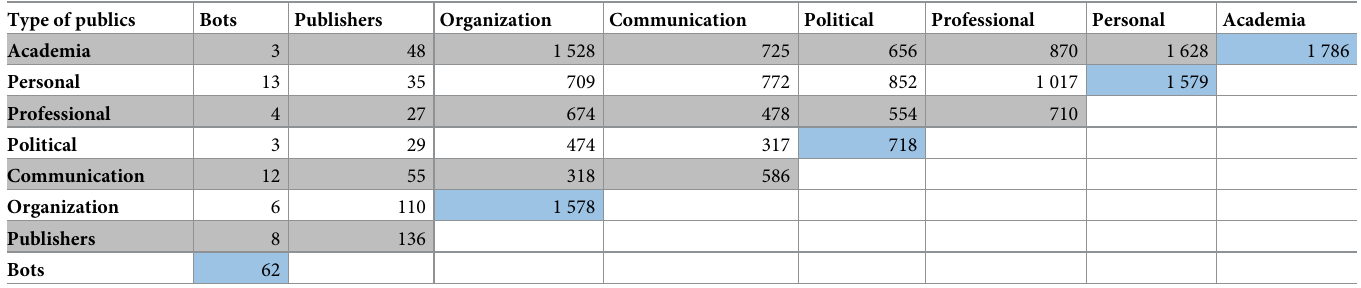
Table 3. Number of Twitter bios with unique of multiple